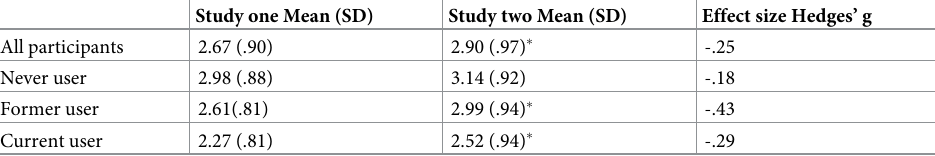
Table 2. E-cigarette harm perception changes between study one and two for never, former, and current users of